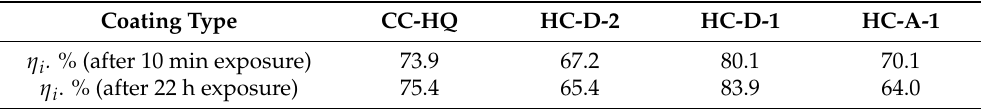
Table 3. Inhibitor efficiency * estimated after 10 min and 22 h of exposure to 3.5 wt.% NaCl